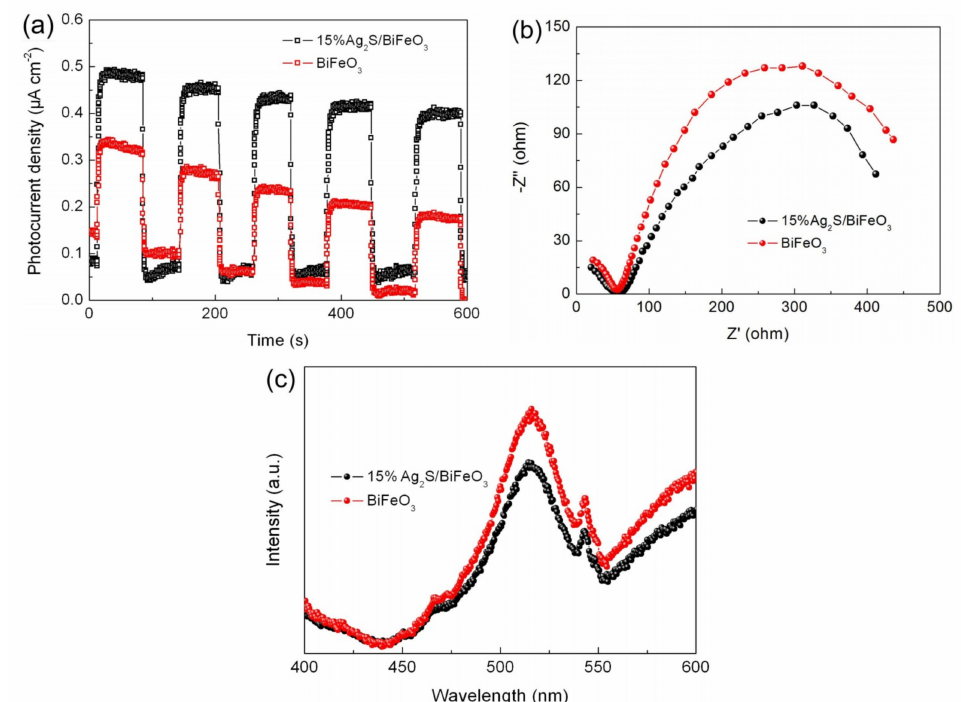
Figure 9. Transient photocurrent response curves under intermittent irradiation with visible light ( a ), Nyquist plots of the electrochemical impedance spectroscopy (EIS) spectra under visible-light irradiation ( b ), and PL spectra ( c ) of BiFeO 3 , and 15% Ag 2 S/BiFeO 3